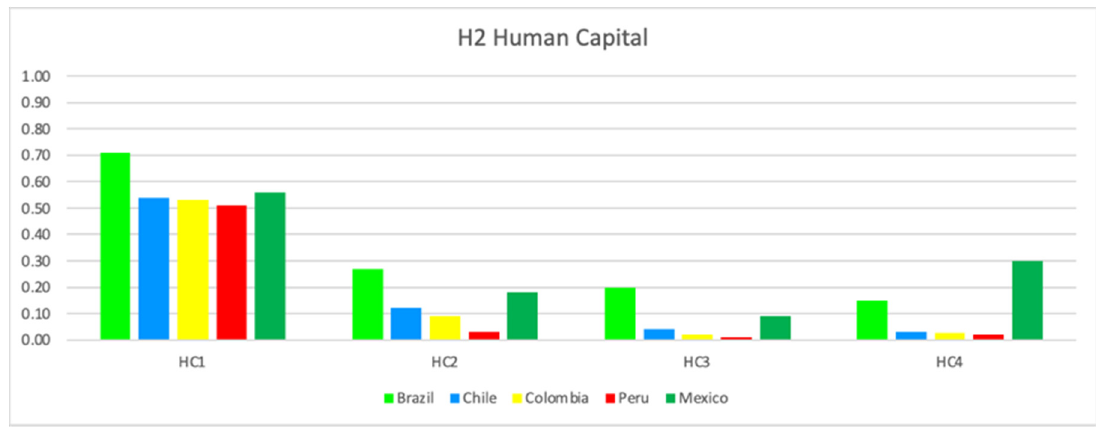
Figure 3. Human Capital (HC). Source: Own elaboration based on [45–48].